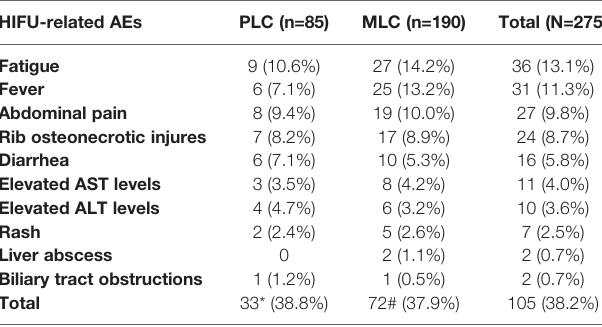
TABLE 4 | Most Frequent HIFU-related Adverse